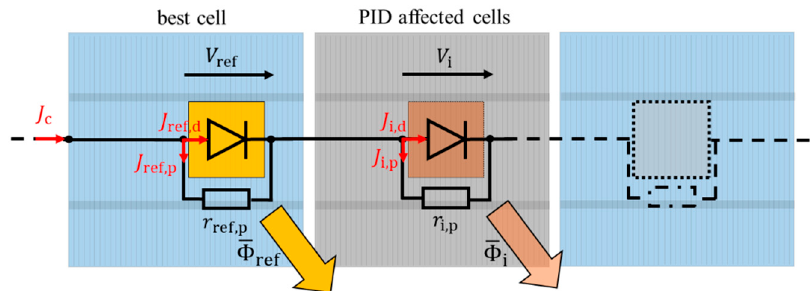
Figure 3. Equivalent circuit for referencing the mean luminescence Φ i of individual cells i (PID affected cells) to the cell with the maximal mean luminescence Φ ref (best cell). The cell current density J c is identical for all cells connected in series and for each cell i divided into the current J i,p through the parallel resistance and the current density J i,d through the local